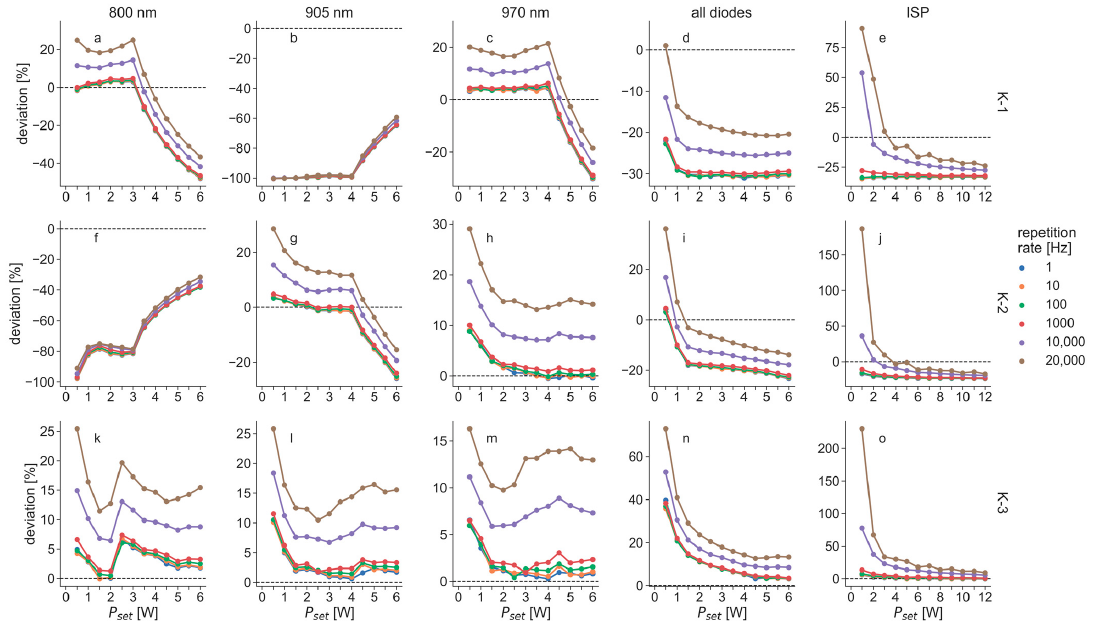
Figure 6. Relative deviation of measured power compared to set power as a percentage for the three K-lasers (K-1, ( a – e ); K-2, ( f – j ); K-3, ( k – o )) operated in pulsed wave mode at varying repetition rates. Values were computed from measured power values that are shown in Figure 5. Dashed horizontal lines at zero in each diagram illustrate ideal curves.